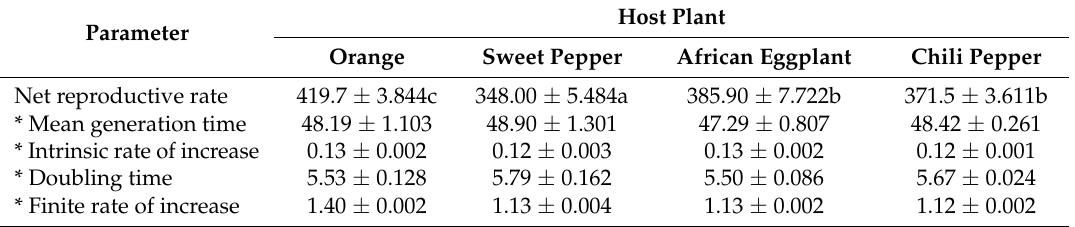
Table 6. Life history parameters of Thaumatotibia leucotreta recovered from orange and solanaceous vegetables.